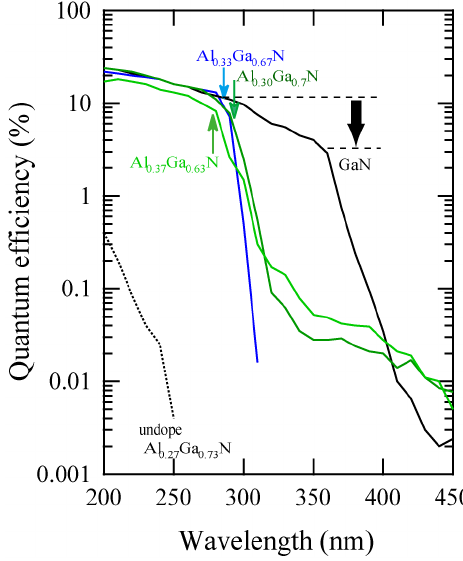
Figure 8. Wavelength dependence of quantum efficiency for photocathodes of Mg-doped